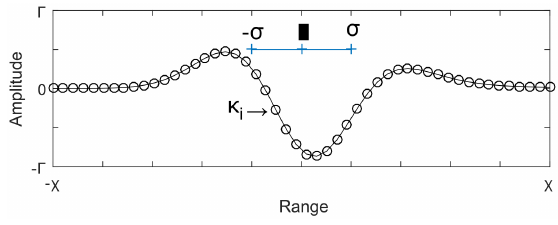
Figure 5. Parameters required to design a kernel of